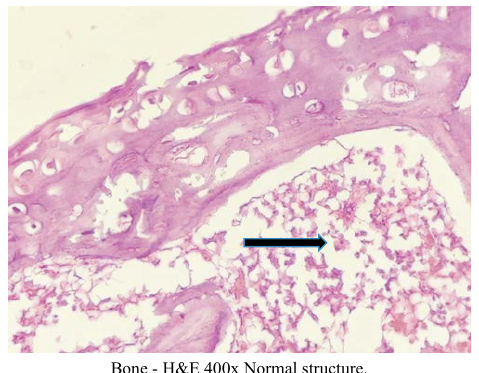
Bone - H&E 400x Normal Fig. 10. Histopathology of decalcified bone of group 10 (Metformin in Diab. group) .